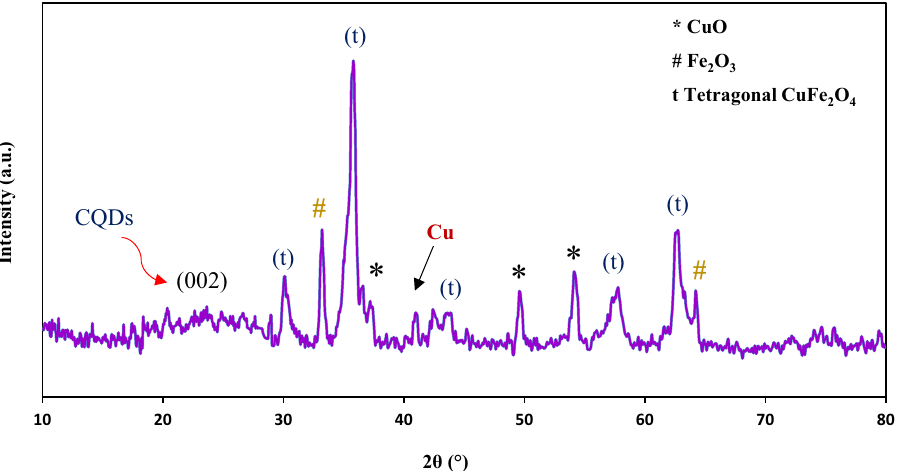
Figure 4. X-ray diffraction pattern of CuFe 2 O 4 @CQD